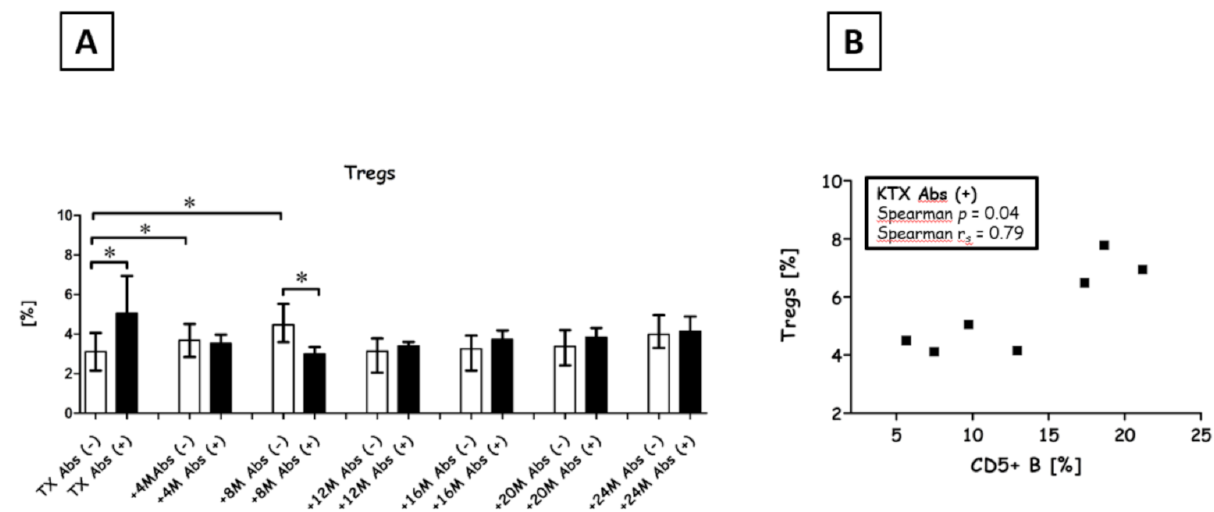
Figure 5. Regulatory T cells during the first 2 y post-transplant. ( A ) Treg levels in Abs − (open circles) and Abs+ (black circles) patients were compared for each measured time point. * p < 0.05 based on Mann-Whitney U tests. The ratio of Abs − to Abs+ recipients at measured time points was as follows: transplant (45/7), +4 months (42/9), +8 months (40/12), +12 months (37/14), +16 months (35/15), +20 months (33/17) and +24 months (32/19). ( B ) Correlation between Tregs ( n = 7) and CD5+ B cells ( n = 7) before transplant in Abs+ recipients, as determined with Spearman rank correlation tests (r s , significant if p <